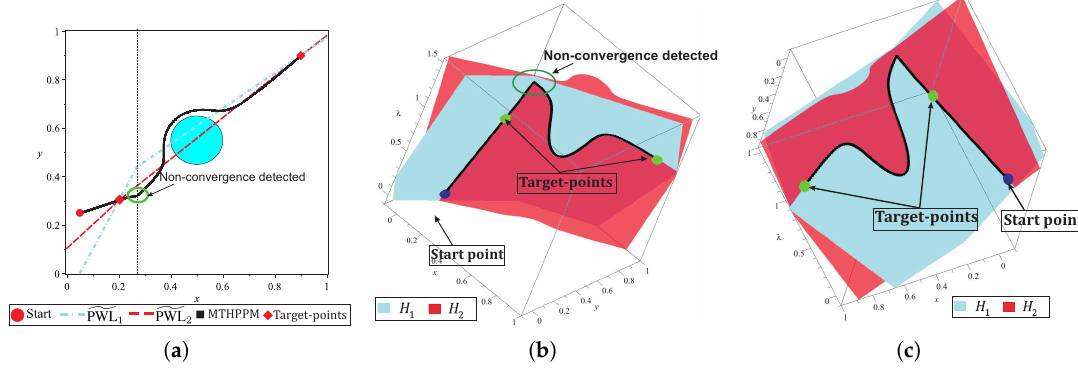
Figure 11. 2-D and 3-D representation of the solution path. ( a ) Solution path 2-D representation. ( b ) Solution path 3-D representation (View 1). ( c ) Solution path 3-D representation (View